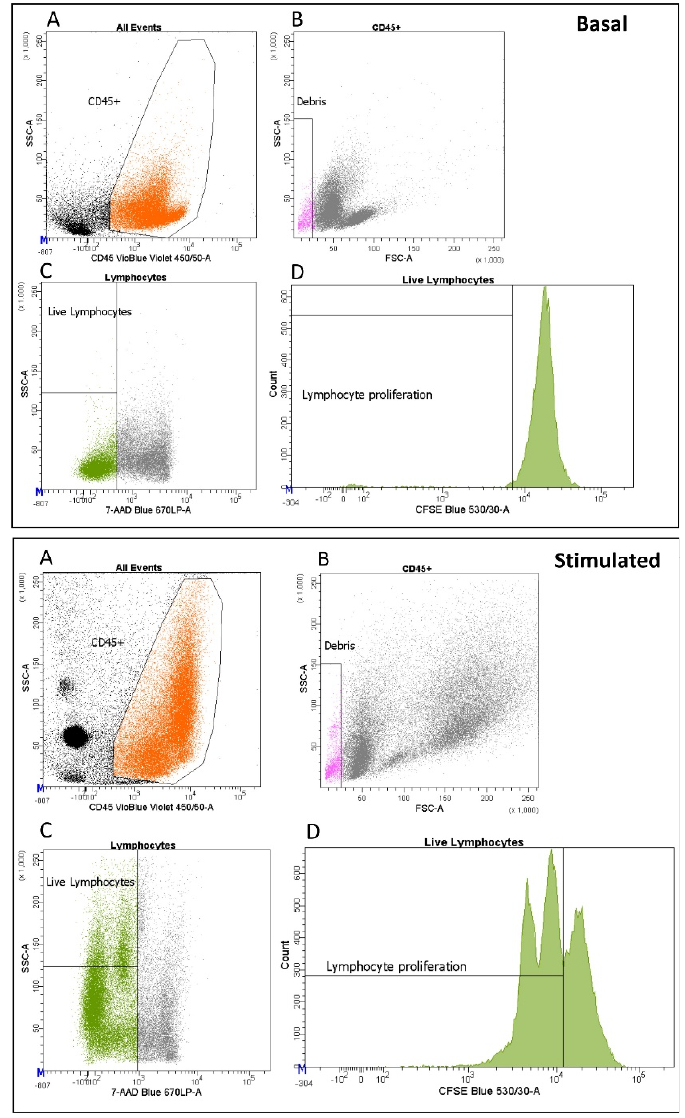
Figure 4. Proliferation activity of a representative sample. ( A ) Lymphocytes (orange) were identified by morphological parameter and CD45 positivity. ( B ) Debris (pink) were removed. ( C ) The remaining 7 ‐ AAD negative events correspond to live lymphocytes (green). ( D ) Proliferation was assessed by CFSE (carboxyfluorescein diacetate succinimidyl ester) at basal level and after stimulation.